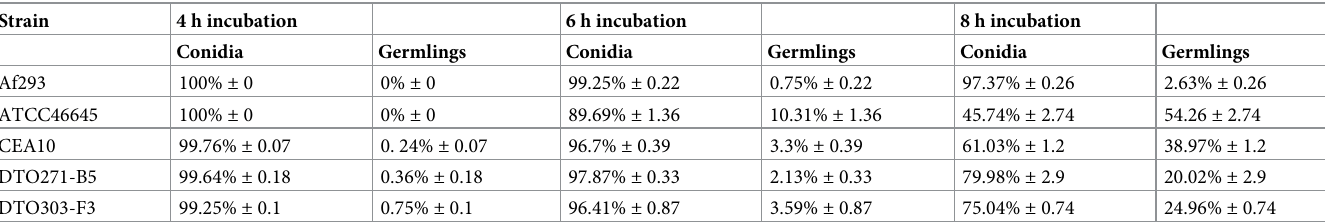
Table 1. Percentage ( ± SE) of germ tube formation after 4, 6 or 8 h swelling in Czapek-Dox medium (CZD) medium at 37˚C. Strain 4 h